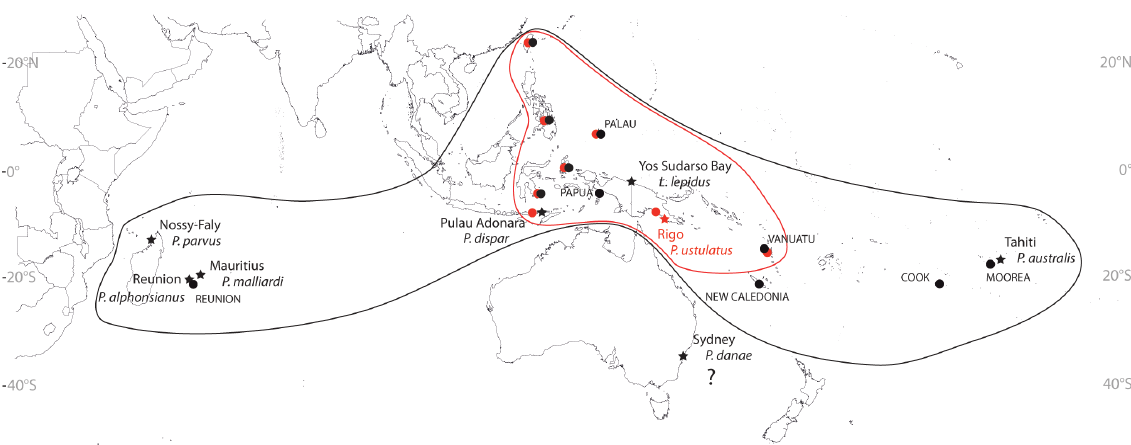
Fig. 1. Map of the Indo-Pacific showing localities where Macrobrachium australe (Guérin-Méneville, 1838 in Guérin-Méneville 1829–1838) (black area) and M. ustulatum (Nobili, 1899) (red area) were collected and/or recorded. Capitalized locality names correspond to the 7 localities sampled for this study. Non-capitalized locality names correspond to the localities reported from the literature. Stars shows the type localities of the synonyms of M. australe (black stars) and M. ustulatum (red